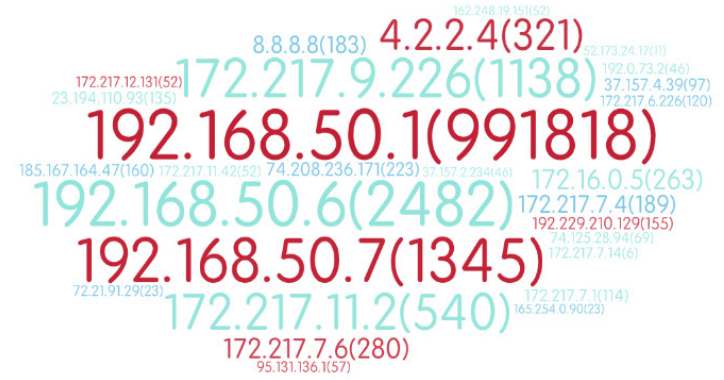
Figure 7. Frequency Diagram of Pseudo IP Addresses.